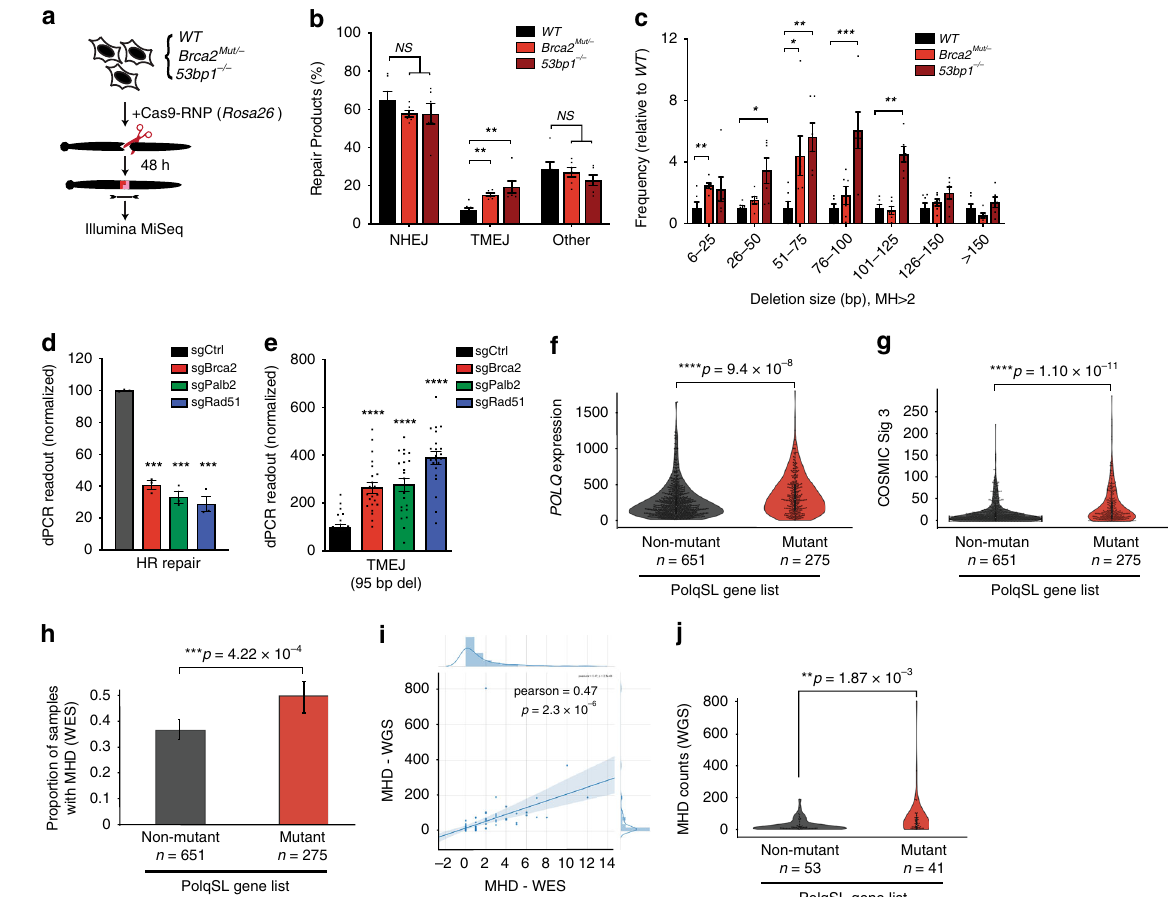
Fig. 6 Elevated TMEJ repair signatures in cells and cancers with PolqSL gene mutations. a WT , 53bp1 − / − , and Brca2 Mut/ − MEFs were transfected with Cas9 ribonucleoprotein (Cas9-RNP) targeting the Rosa26 locus. Forty-eight hours later the targeted region was ampli fi ed and analyzed by high throughput sequencing (Illumina MiSeq). b Percentage of repair products classi fi ed as NHEJ ( ≤ 5 bp del, or 1 – 3 bp insertion), TMEJ (>5 bp deletion and >2 bp MH), and “ Other ” (>5 bp deletion and 0 – 2 bp MH), for the indicated MEF genotypes. c The relative frequency (normalized to WT ) of end joining products with >2 bp MH and deletion size within the indicated ranges. 53bp1 − / − MEFs are associated with larger-sized TMEJ signature deletions. b , c Mean values ± SEM ( n